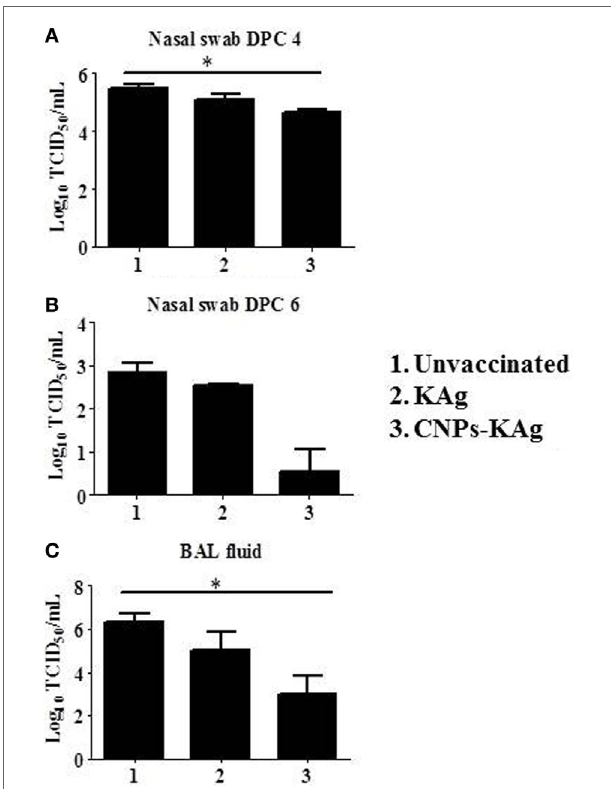
FigUre 10 | Infectious challenge swine influenza A virus (SwIAV) H1N1 titer in the respiratory tract of chitosan nanoparticles (CNPs)-KAg-vaccinated and influenza A virus (IAV)-challenged pigs. Titers of challenge SwIAV shedding through nostrils at (a) day post-challenge (DPC) 4 and (B) DPC 6, and in bronchoalveolar lavage (BAL) fluid at DPC 6 (c) determined by using cell culture technique. Data represent the mean value of three to five pigs ± SEM. Statistical analysis was carried out using Kruskal–Wallis test followed by Dunn’s post hoc test. Asterisk refers to the statistical significant difference between the indicated two pig groups (* p <